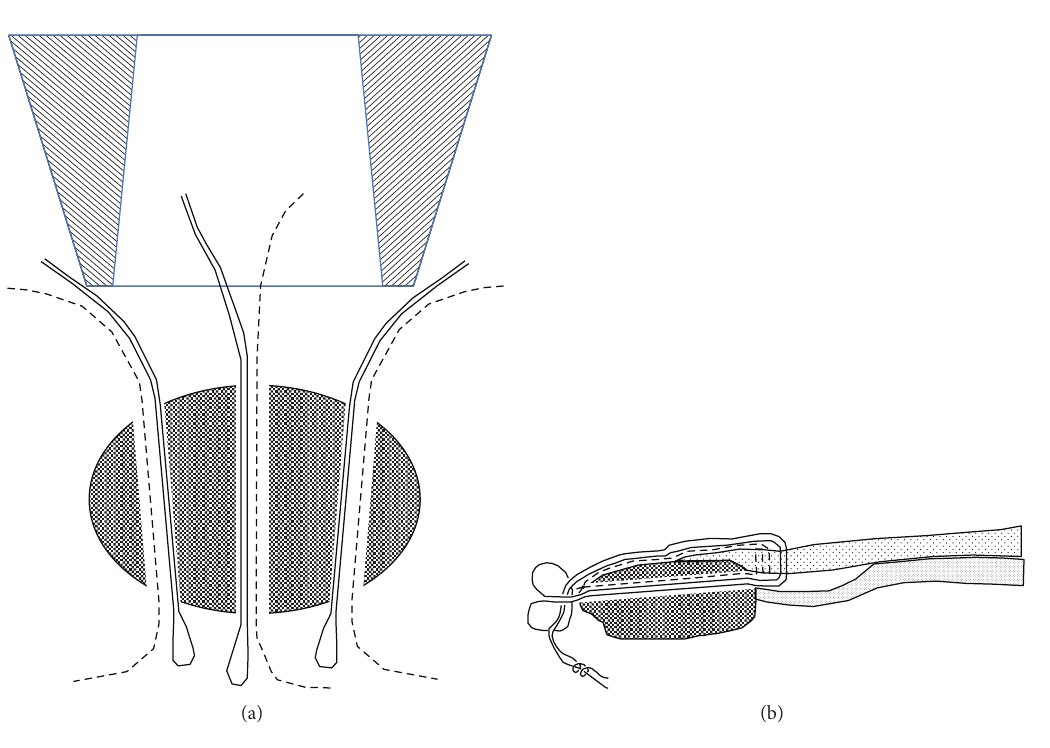
Figure 12: Schema of the arthroscopic suture in Case 2. (a) Two threads (a dotted line for the Mason–Allen method and a solid line for the double-loop sliding knot) were used for the internal, medial, and external bone tunnels. (b) As with Case 1, after the threads were passed through both the superficial layer and the inside of the tunnel of the patella, they were then tied at the lower rim. Subsequently, only the superficial layer was